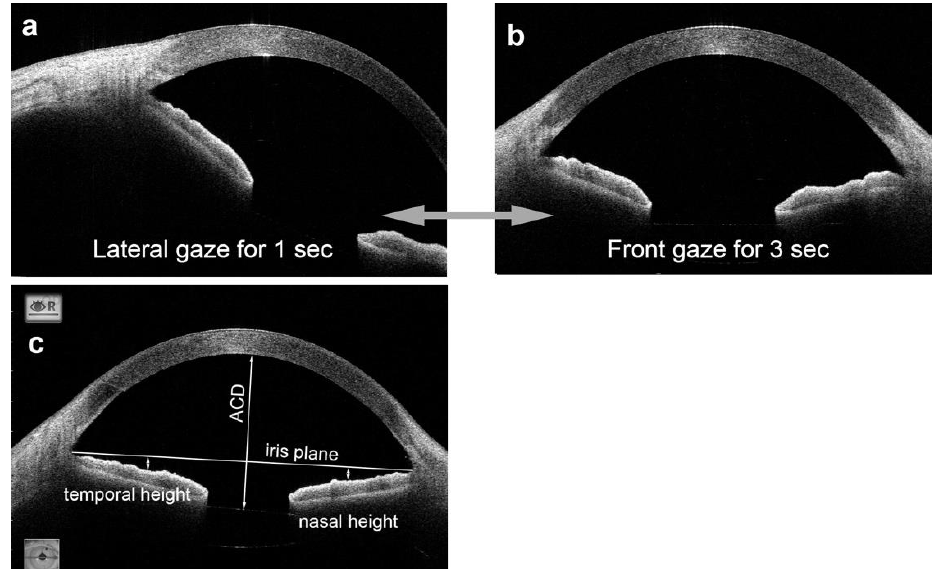
Figure 1. Anterior segment optical coherence tomographic (AS-OCT) images are taken when the eye is fixed on a temporal target and then moves to the primary position. Also shown are images that show the parameters of the AS-OCT images that are measured. ( a ). AS-OCT image when the patient is looking at a point located 30 degrees temporal from the visual axis. ( b ). AS-OCT image taken immediately after the patient has moved the eye to the primary position and holds this position for 3 s. ( c ). The heights of the temporal and nasal sectors of the iris are defined as the distance from the iris plane (the line between anterior chamber angles) to the anterior surface of the nasal and temporal sectors of the mid-iris.